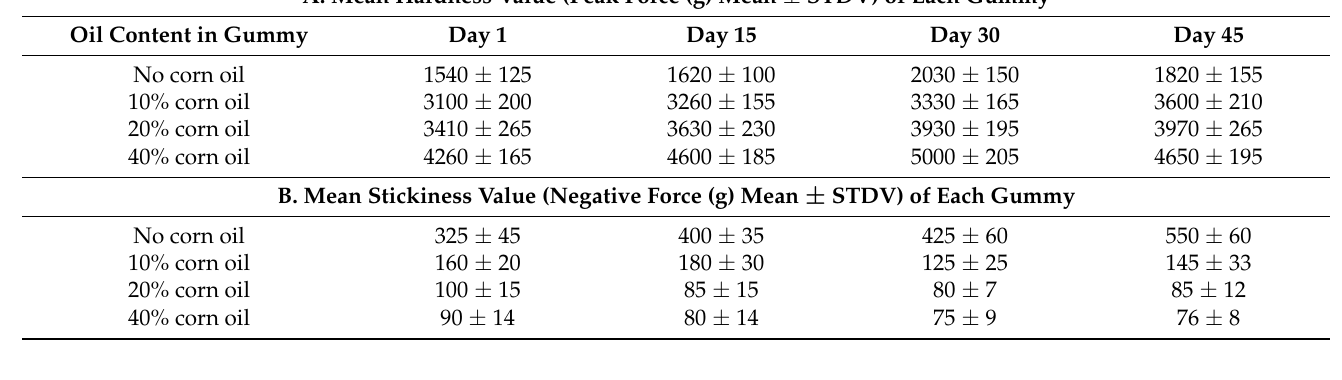
Table 5. ( A ) Mean hardness value (Peak force (g) mean ± STDV) and ( B ) mean stickiness value (negative force (g) mean ± STDV) of each gummy on day 1, 15, 30 and 45. A. Mean Hardness Value (Peak Force (g) Mean ± STDV) of Each Gummy